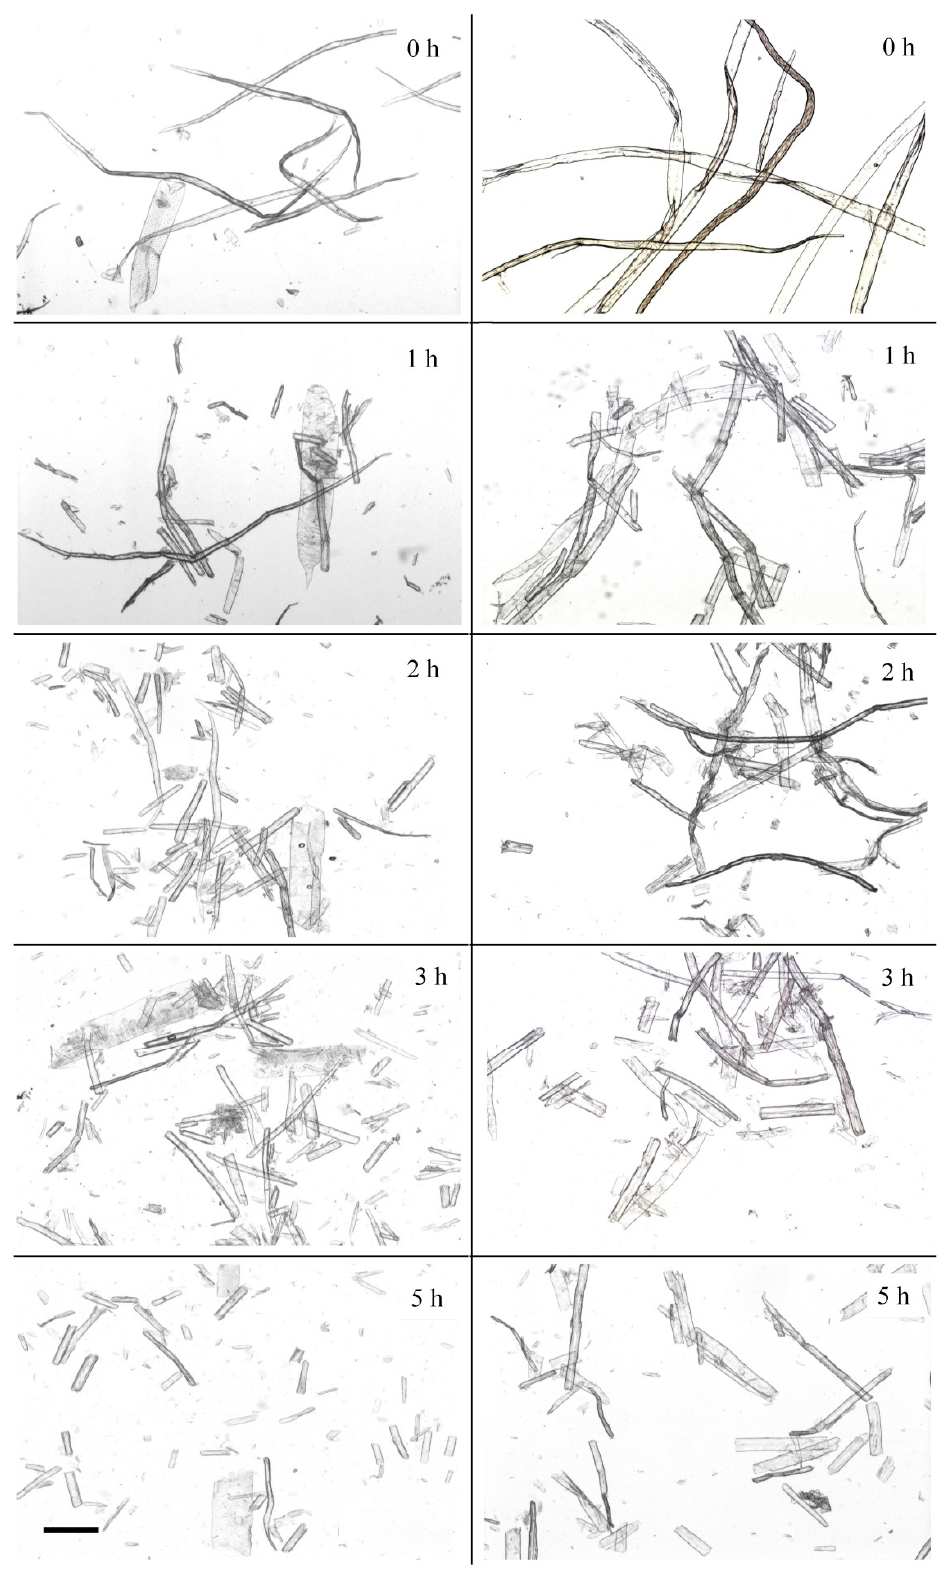
Figure 3. Microscopic images of gradual enzymatic degradation of hardwood (left) and softwood (right) pulp fibers for 5 h. Bar: 0.1 mm.